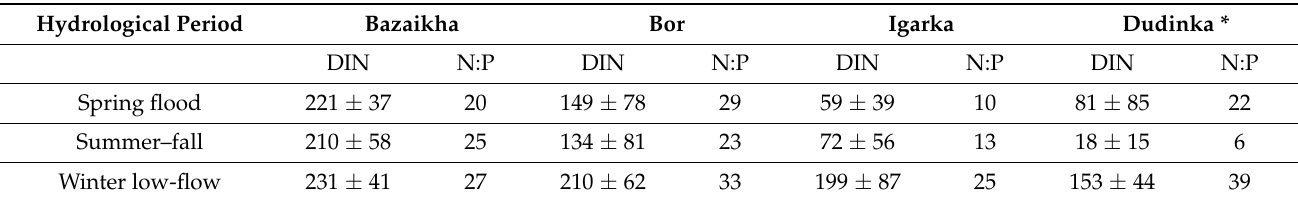
Notes: * data from the Arctic-GRO database.